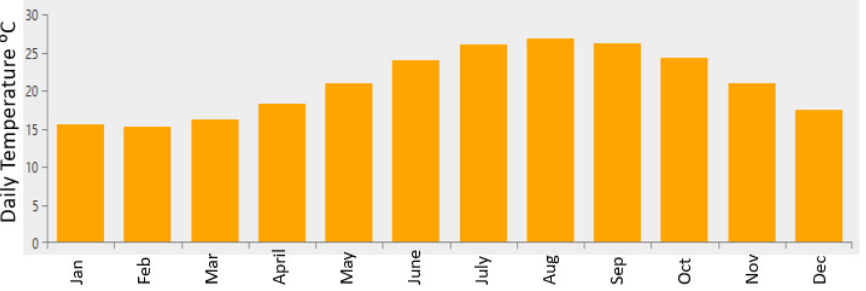
Figure 4. Monthly average air temperature (°C) over a 30-years period (Jan. 1984–Dec. 2013), HOMER Pro.